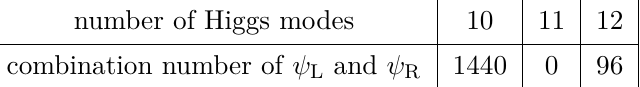
Table 26 . D L = D R = 5 , D H = 20